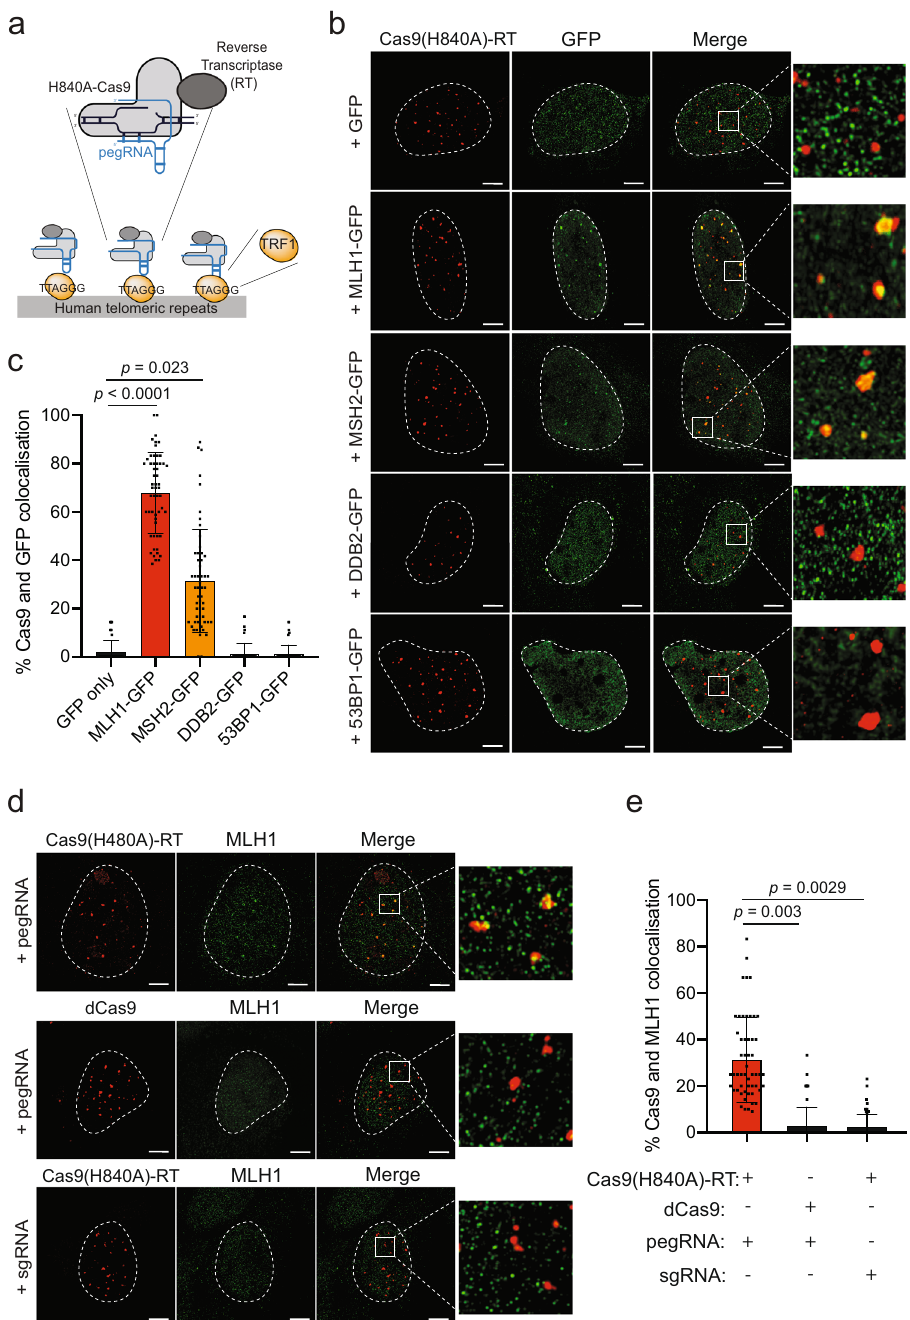
Fig. 2 The mismatch repair protein MLH1 localises to sites of active prime editing. a Scheme of the setup used for imaging. Cas9(H840A)-RT is targeted, through a pegRNA, to human telomeric repetitive regions. TRF1 is a telomeric protein that binds to these regions. b Representative super- resolution images of Cas9(H840A)-RT and the indicated GFP-tagged DNA repair proteins, in U2OS cells 24 h after reverse transfection with GFP or GFP- tagged MLH1, MSH2, DDB2, or 53BP1, as well as a pegRNA targeting telomeric repeats. n = minimum 50 cells examined over three biologically independent experiments. Scale bar = 5 μ m. c Quanti fi cation of b indicating colocalization of Cas9(H840A)-RT foci with GFP foci. n = minimum 50 cells examined over three biologically independent experiments. d Representative super-resolution images of Cas9(H840A)-RT, or dCas9, and MLH1 with a pegRNA or a sgRNA targeting telomeric repeats. n = minimum 50 cells examined over three biologically independent experiments. Scale bar = 5 μ m. e Quanti fi cation of d , indicating colocalization of Cas9(H840A)-RT foci with MLH1 foci. n = minimum 50 cells examined over three biologically independent experiments. Statistical analysis using unpaired two-tailed Student ’ s t -test across biological replicates only. Error bars re fl ect mean ± s.e.m. Source data are provided as a Source Data fi